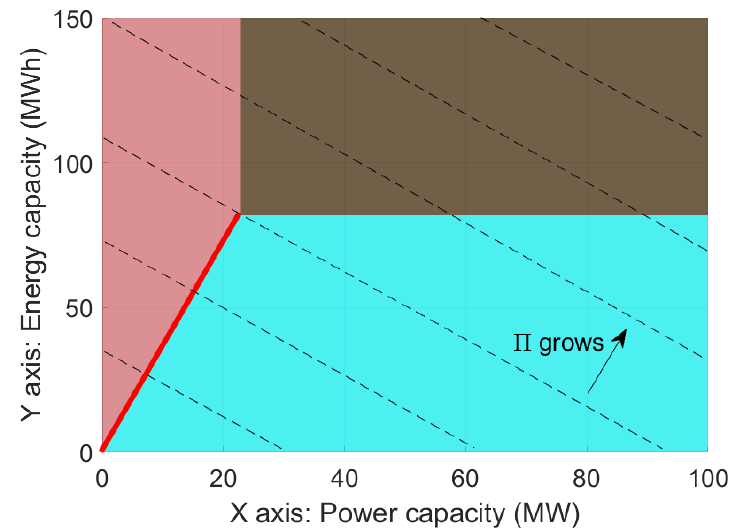
Figure 5. Critical regions with isocost curves.